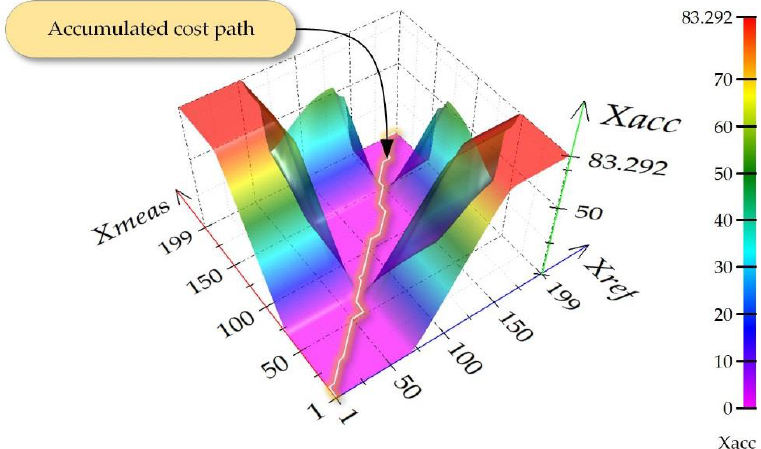
Figure 5. Visualization of a data matrix containing a so called cumulated cost and the least value path.